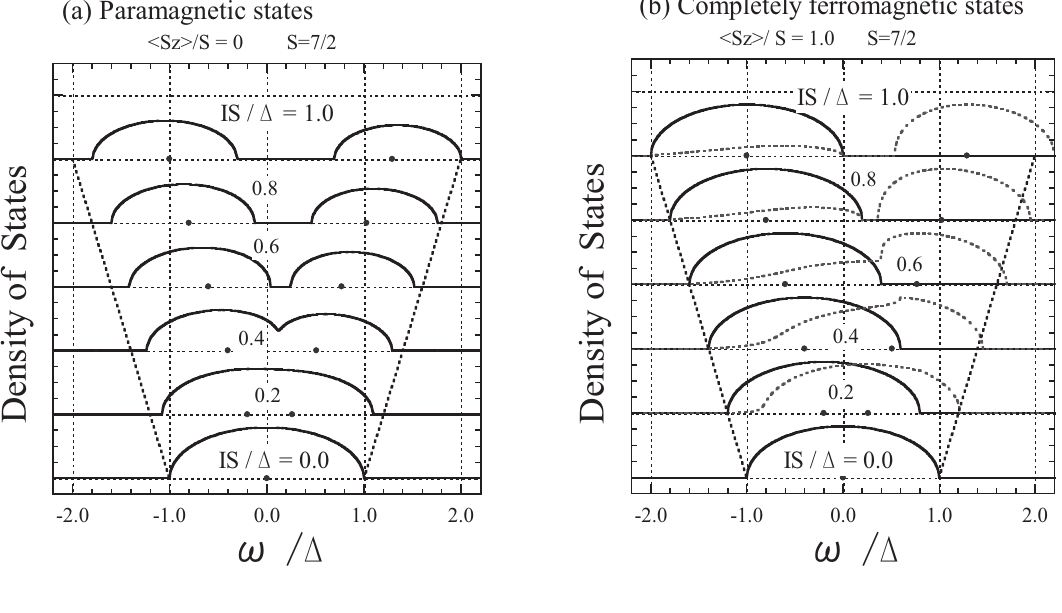
Figure 1. The DOS shown as a function of ! / ∆ for IS / ∆ = 0.0, 0.2, 0.4, 0.6, ⟩ = 0; left panel) and (b) completely 0.8, and 1.0: (a) paramagnetic states ( ⟨ S z ⟩ = S; right panel). The solid curves show up-spin states ferromagnetic states ( ⟨ S z and the dotted curves show down-spin states. The points on the energy axes indicate − IS and + I ( S + 1) , and the straight dotted lines indicate − (∆ + IS ) and +(∆ + IS ) for